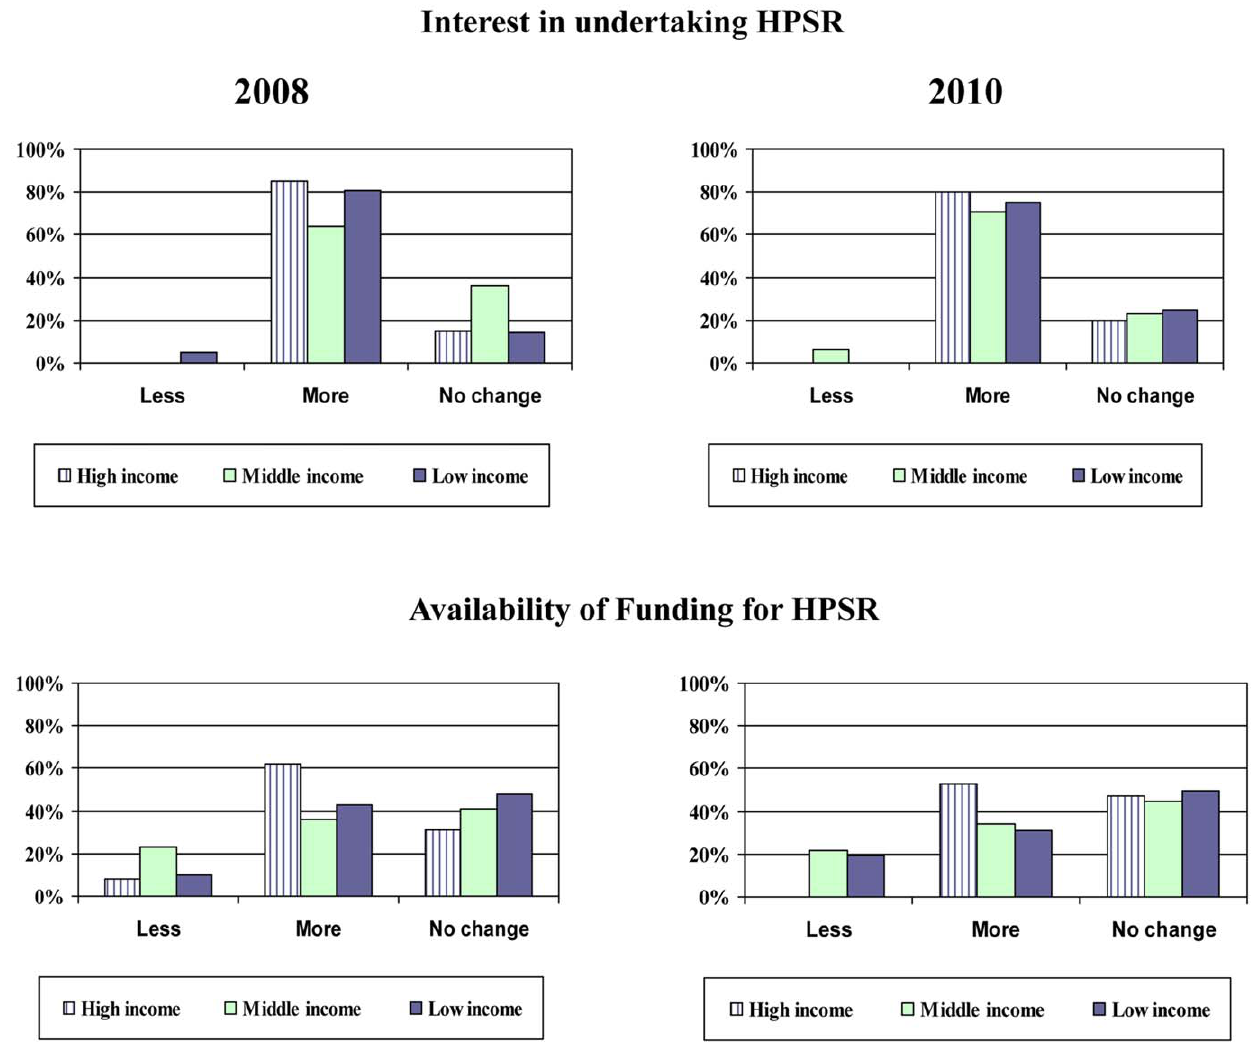
Figure 5. Perception of availability of funding and interest in HPSR in 2008 and 2010.